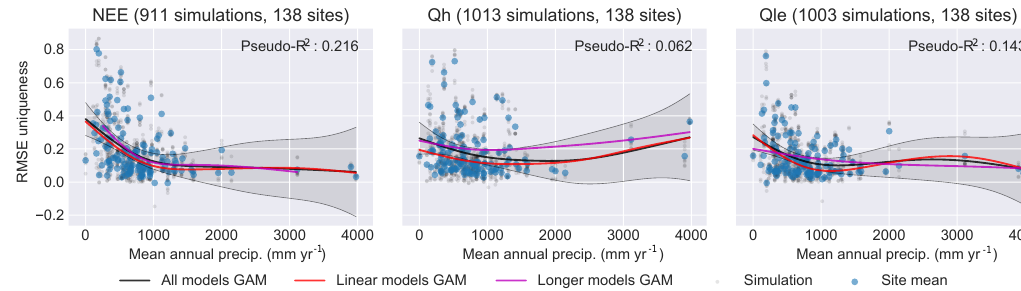
Figure 3. RMSE uniqueness for mean annual precipitation.